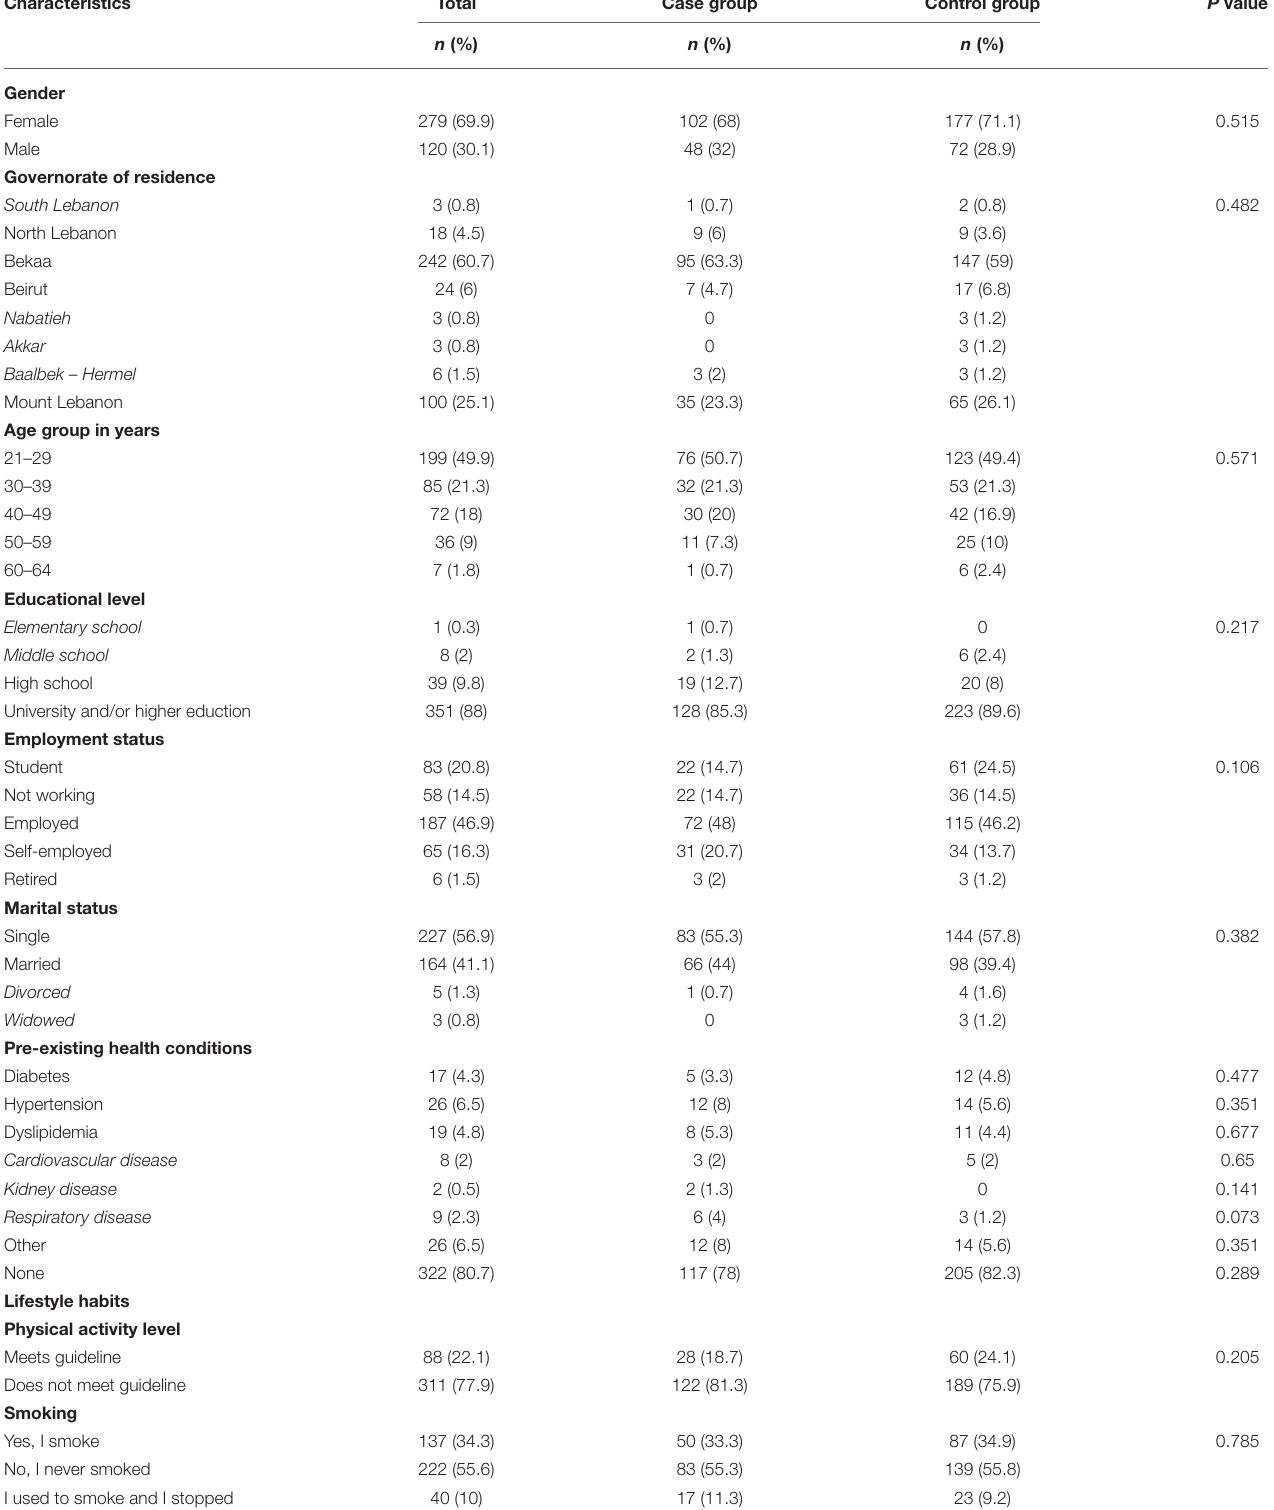
TABLE 1 | Sociodemographic characteristics, health status and lifestyle habits of the participants.